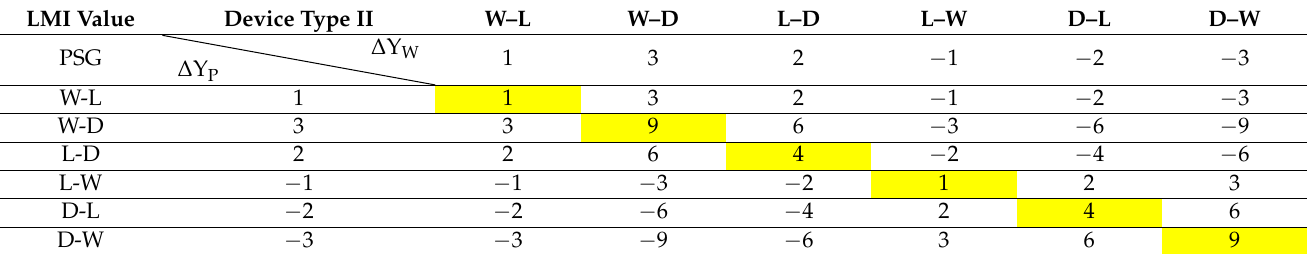
Table 4. Implementation of the proposed evaluation. -Data preparation +Synchronize and align the data using clock time of the host computer +Specify the AASM sleep scoring category of the wearable device +Establish agreement among sleep raters on the PSG hypgram -General features and sleep stage distribution evaluation +Extract general sleep features +Extract sleep state distribution features -Localized quantifier